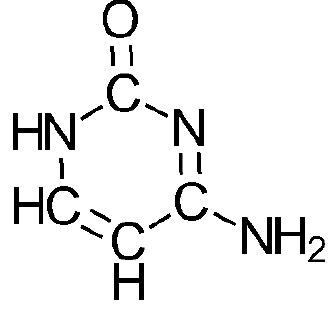
Figure 10. Structure of cytosine. Table 4. The gradual growth of cytosine.